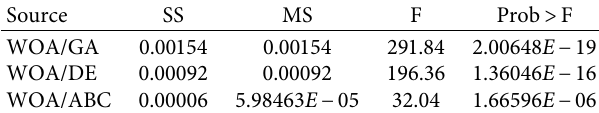
Table 4: Analysis results of